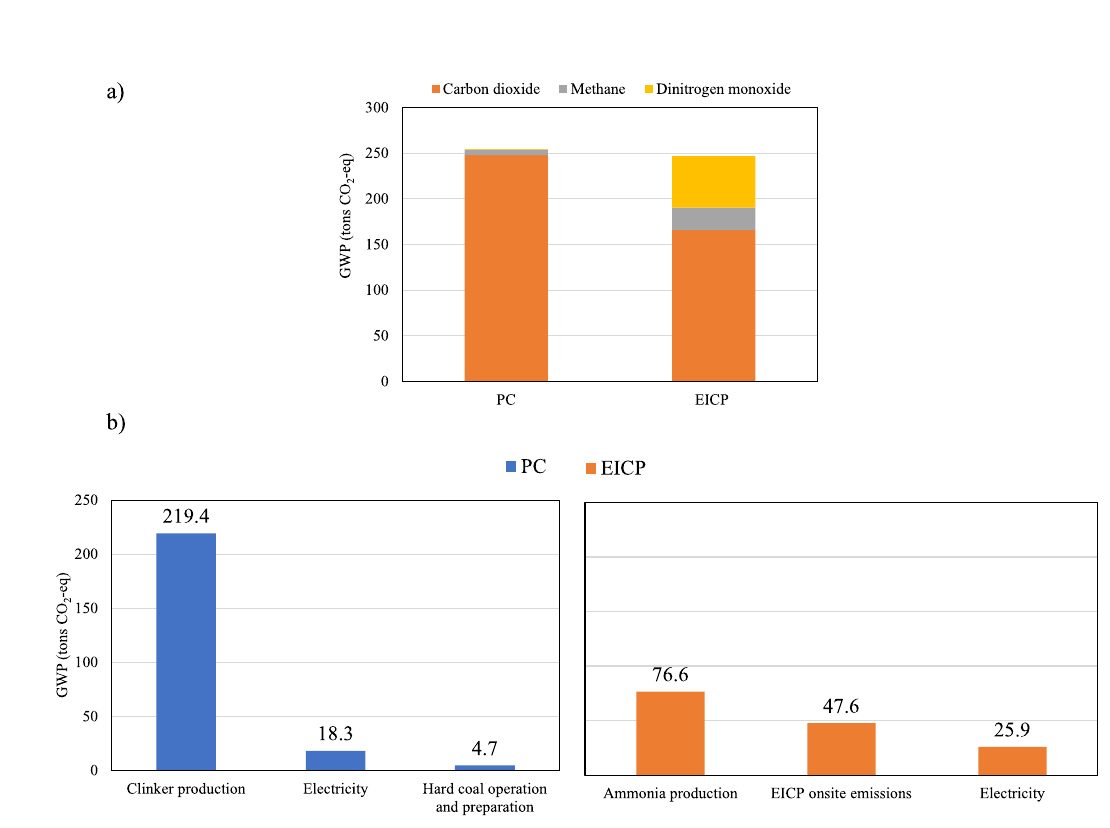
Table 2. Sensitivity analysis scenarios for EICP, PC, and MICP treated sand at various target UCS values. *Adjusted to current FU (treatment of 1500 m 3 soil volume).